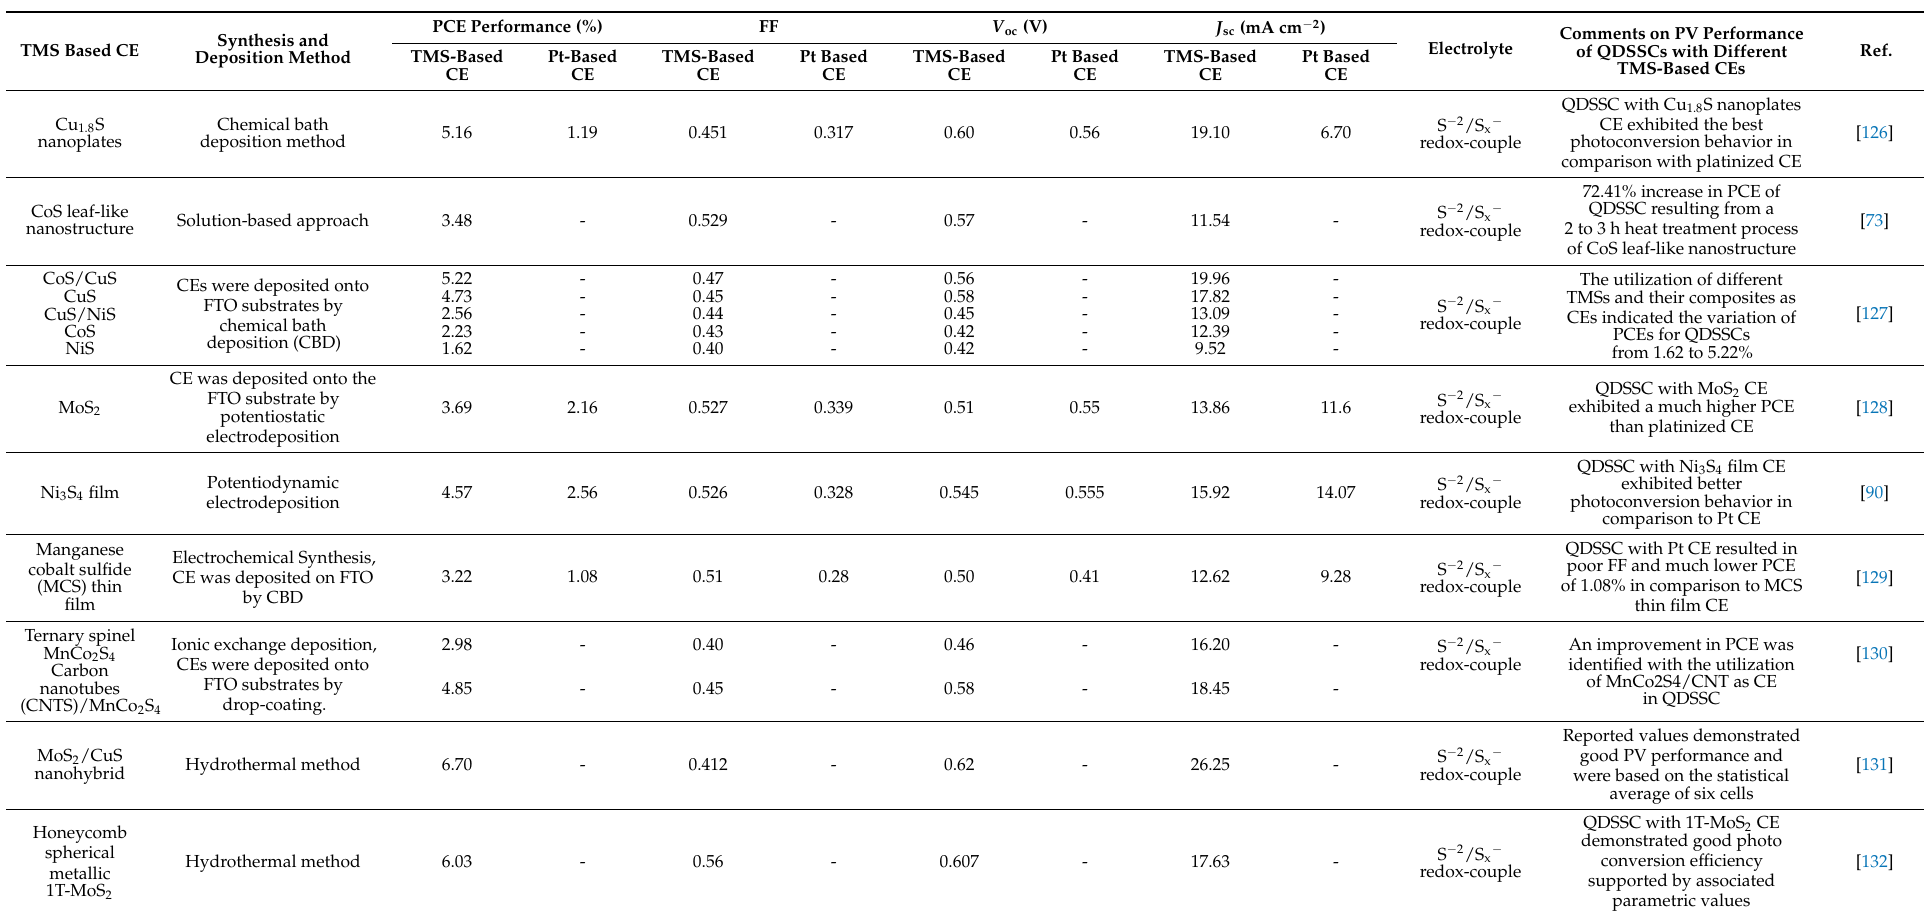
Table 2. Summary of TMS-based CEs synthesized and applied in QDSSCs. The resulting PV performances (PCE, FF, V oc , and J sc ) values of QDSSCs with TMS-based CEs are compared with those of QDSSCs with Pt-based